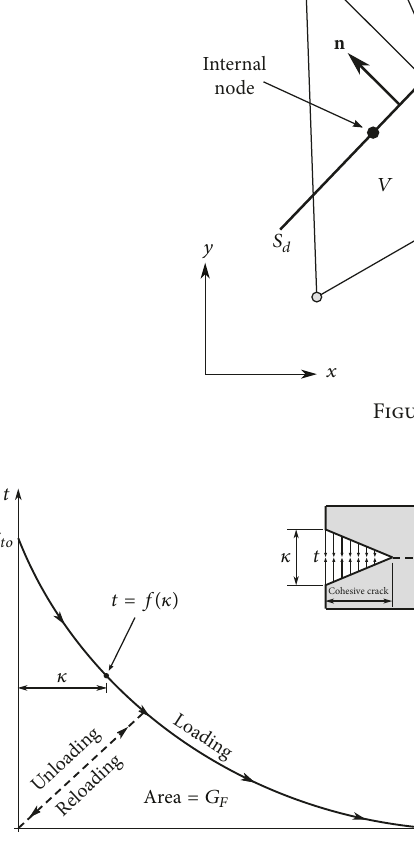
Figure 5: Cohesive crack model.